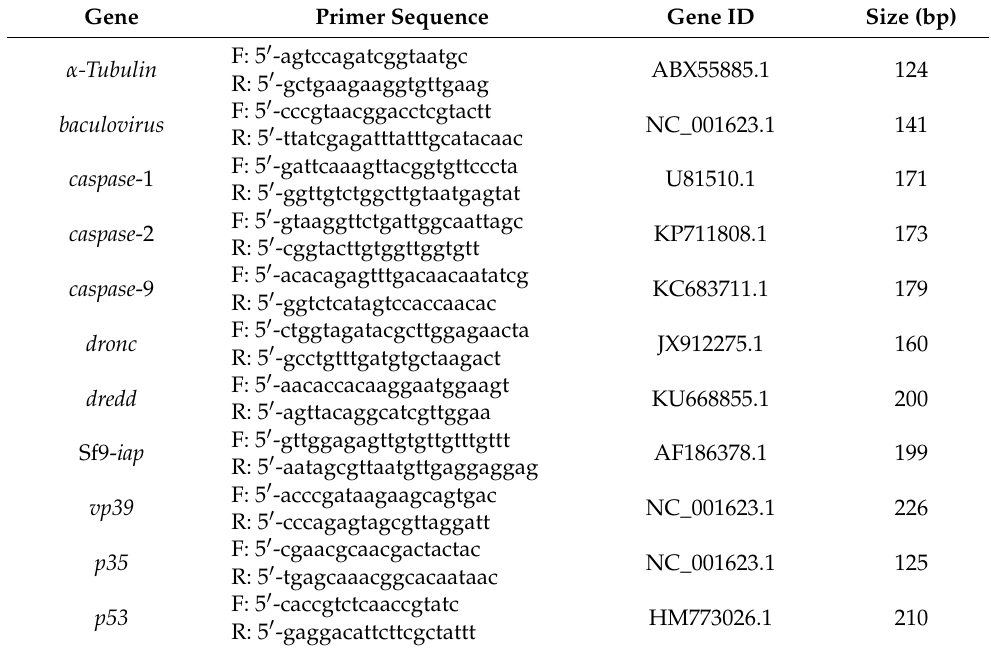
Table 2. Primers used for